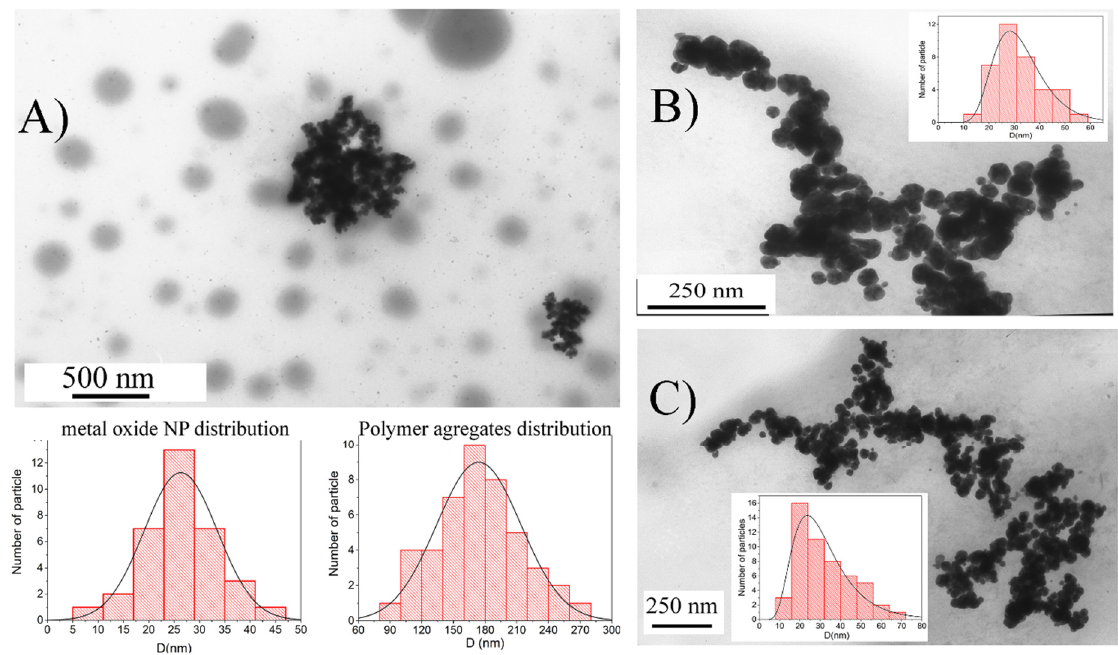
Figure 1. TEM image of particles ChemRed-NP ( A ), US/TermRed-NP ( B ), US-NP ( C ) with inserts of histogram of particle size distribution.